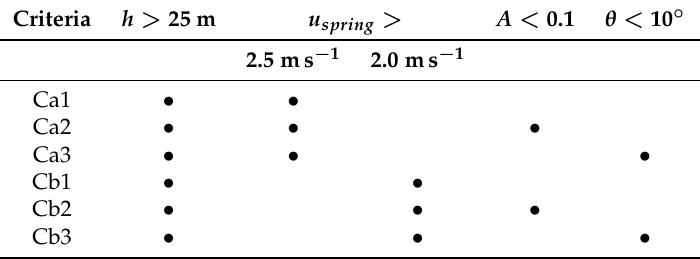
Table 1. Criteria adopted for the cartography of potential tidal stream energy sites.